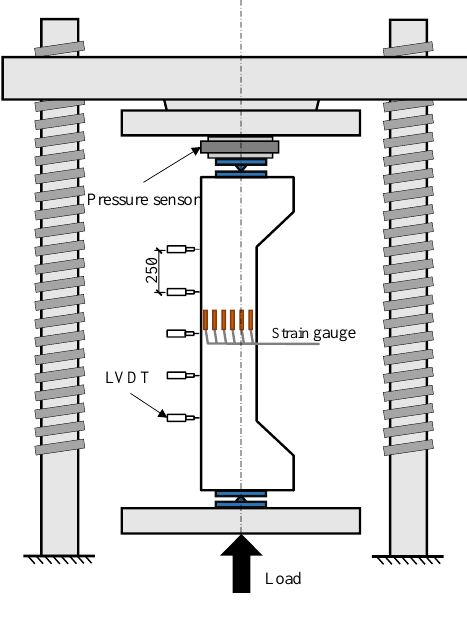
Figure 2. Test setup.